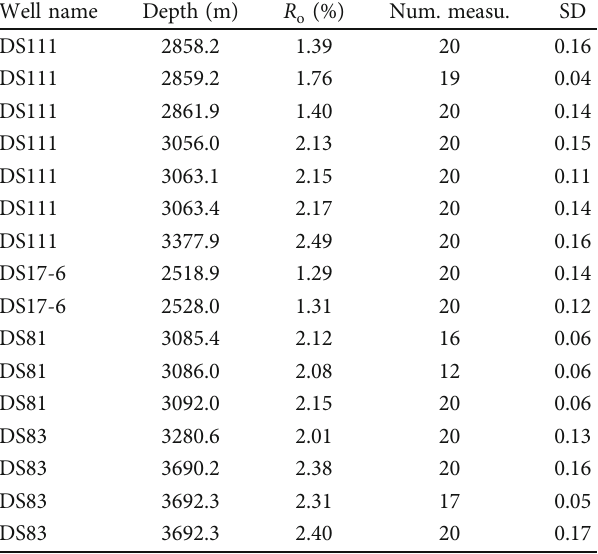
R Figure 7: (a) T max and (b) o versus depth for the K 1 yc source rocks samples. Thermal maturity zones are divided according to Peters and Cassa [39]. Table 2: Results of vitrinite re fl ectance